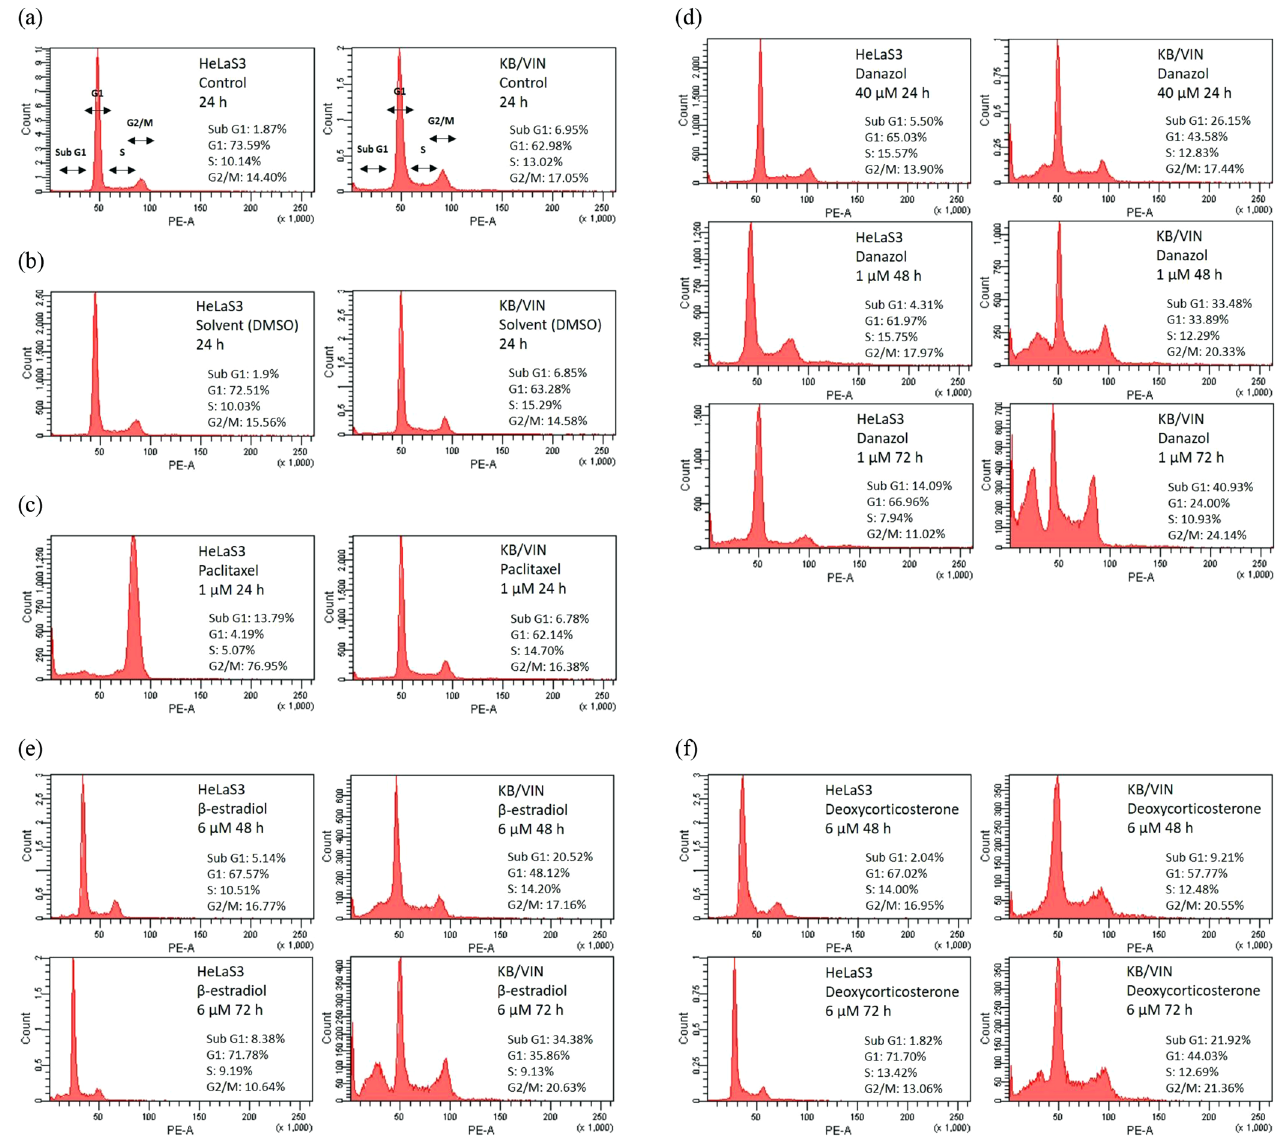
Figure 3. Results of cell cycle analysis in HeLaS3 and MDR KB/VIN cells. HeLaS3 and KB/VIN were treated with culture medium ( a ), DMSO ( b ), paclitaxel ( c ; positive control), danazol ( d ), β -estradiol ( e ), and deoxycorticosterone ( f ) for 24, 48, and 72 hours. DNA contents and cell cycle distribution of each sample were determined by PI solution (X-axis PE). Danazol, β -estradiol, and deoxycorticosterone arrested KB/VIN cell at G2/M phase and caused apoptosis (increased sub G1) in a time-dependent